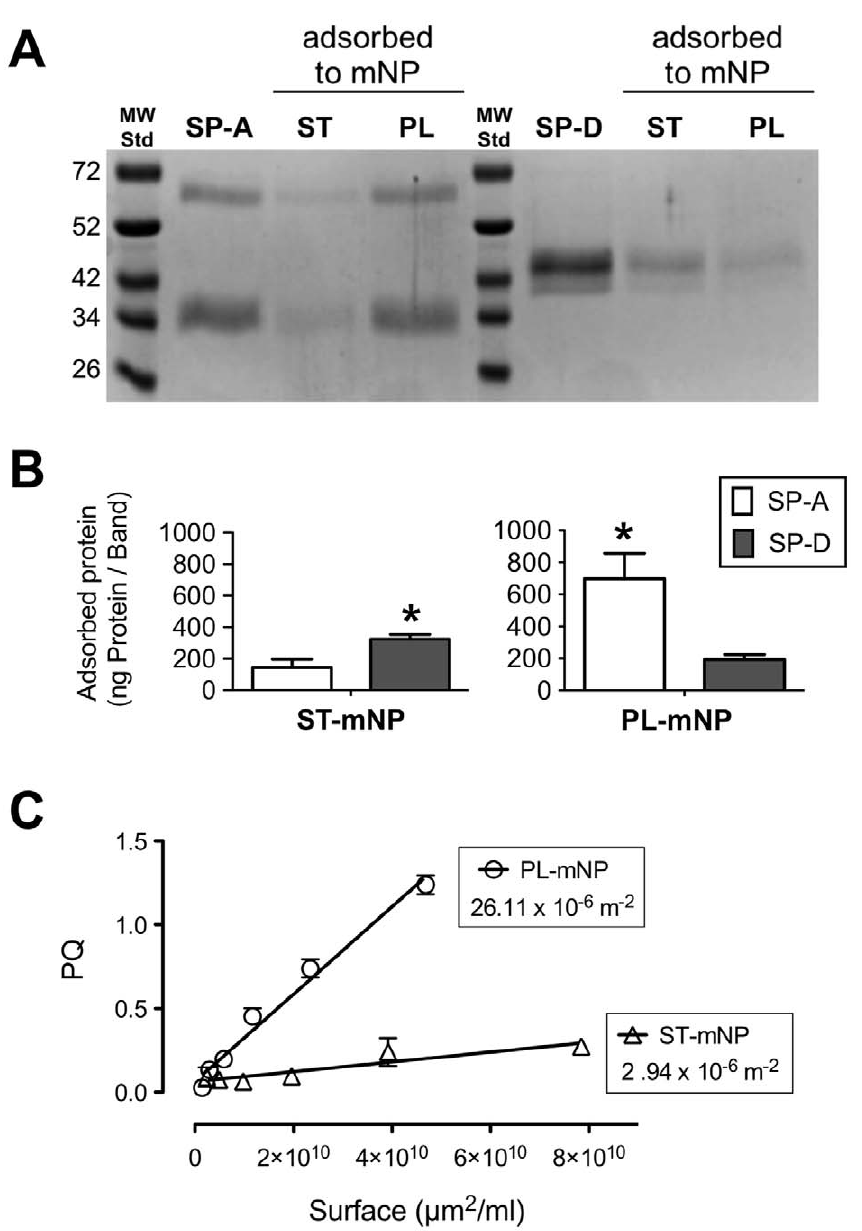
Figure 3. Adsorption of SP-A and SP-D to nanoparticles as affected by particle coating and hydrophobicity. (A) Representative SDS- PAGE gel displaying the adsorbed surfactant proteins (SP-A in the left lanes or SP-D in the right lanes) eluted from Starch- (ST) or Phosphatidylcholine-modified (PL) magnetite nanoparticles (mNP); MWStd stands for molecular weight standard. (B) Adsorbed amount of protein in nanogram of protein per band. (C) Plot of Rose Bengal – partitioning coefficient (PQ) as a function of total nanoparticle surface area ( m m 2 ). The slope of the lines was considered as a measure of relative nanoparticle hydrophobicity. Data shown as mean 6 SD (n=3). Significant differences between the two proteins are indicated with asterisks (p , 0.05).